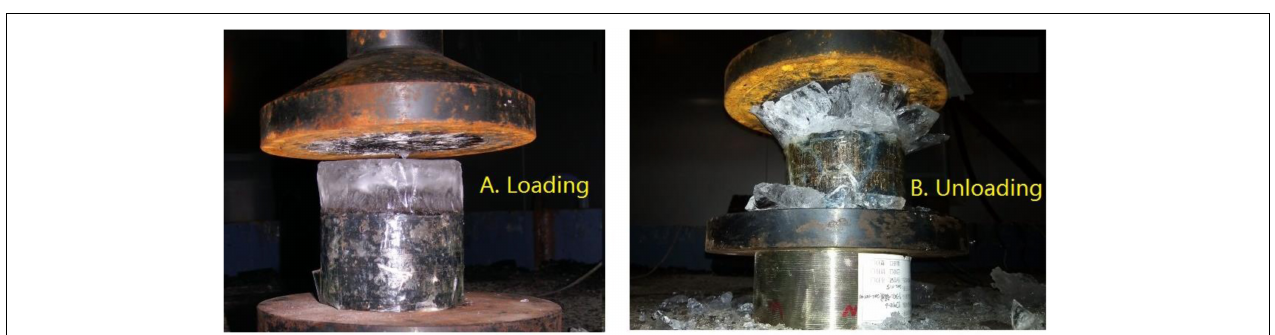
FIGURE 4 | Load–displacement and stress–strain curve of Marshall specimen for –4 ◦ C.